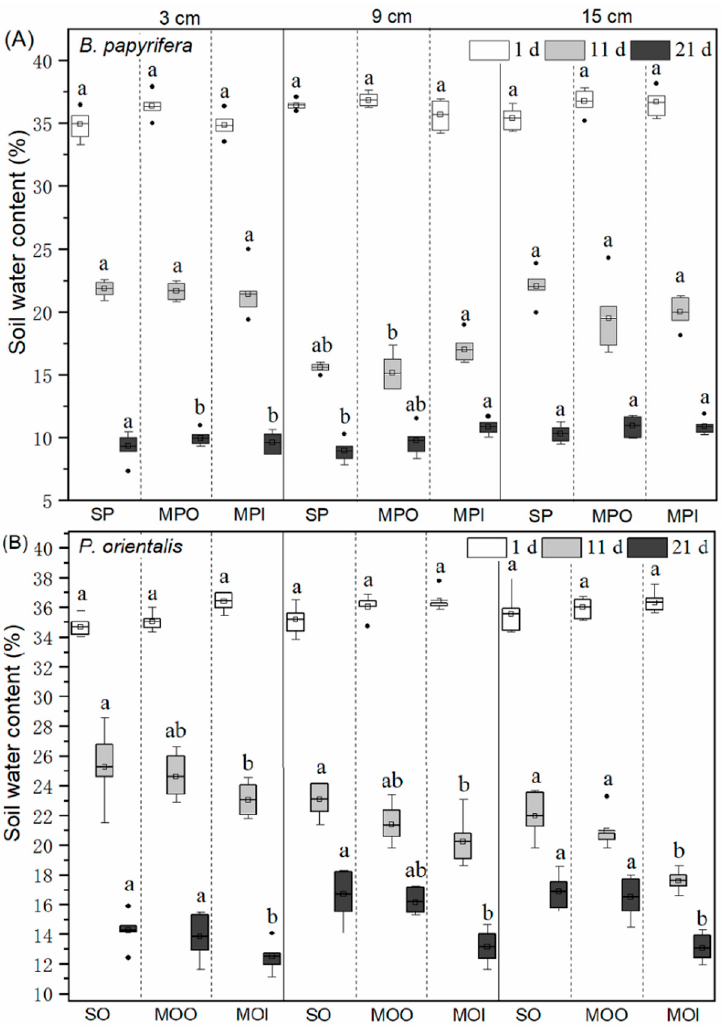
Figure 2. Soil water contents in the rhizosphere of B. papyrifera ( A ) and P. orientalis ( B ). Letters denote significant differences among soil sampling points ( p < 0.05). SP— B. papyrifera under solo planting, MPO—outside of B. papyrifera under mixed planting, MPI—inside of B. papyrifera under mixed planting, SO— P. orientalis under mixed planting, MOO—outside of P. orientalis under mixed planting, MOI—inside of P. orientalis under mixed planting.